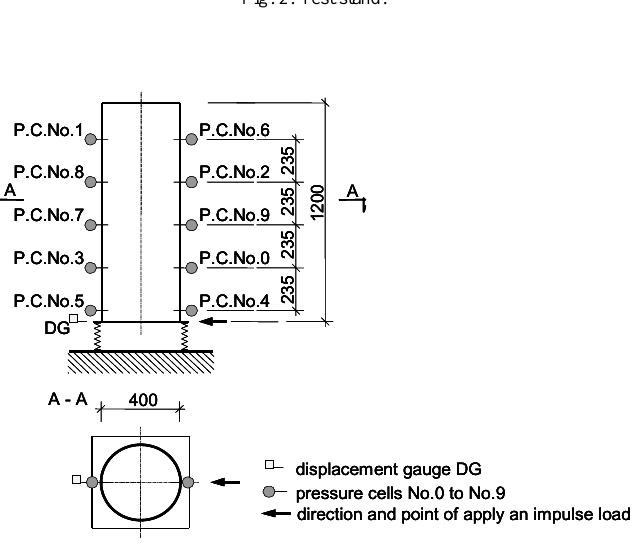
Fig. 3. Arrangement of pressure cells on